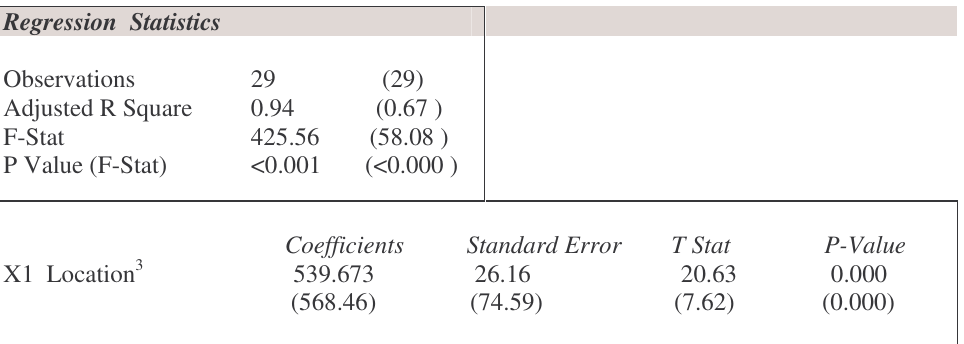
Table 1: Regression 2005: sales volume versus location 3 (2004 in